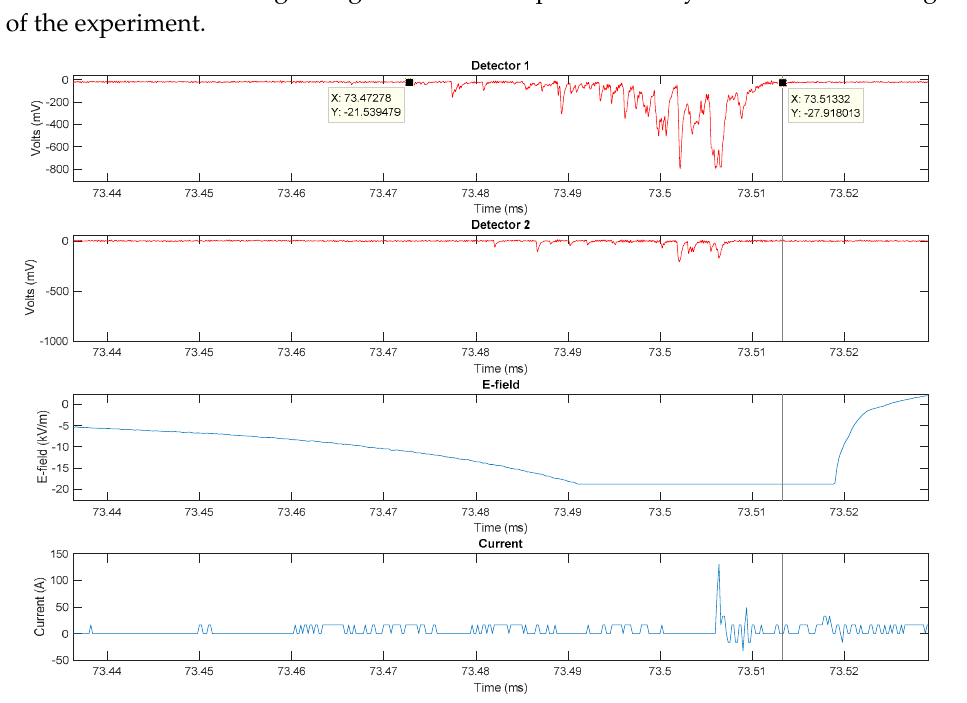
Figure 3. X-ray burst associated with the third (second subsequent) return stroke. The time t = 0 corresponds to 16:09:36.072213 UTC. X-rays are detected in both attenuated (detector 2) and unattenuated (detector 1) detectors. According to the Austrian Lightning Detection and Information System (ALDIS), this 36-kA stroke occurred at a distance of 400 m from the tower. Peak energy of the burst, derived from roughly − 800 mV peak in the un-attenuated detector, is about 4.3 MeV (this could be due to a multi-photon accumulation). The two cursor positions indicate the first and the last occurrence of X-ray peaks. This last occurrence, also shown in the black vertical cursor, happens roughly 1.4 µ s before the return stroke (RS) time of 16:09:36.145867 UTC as recorded by the ALDIS. The total duration of bursts is about 40 µ s. The seemingly continuous nature of bursts (in detector 1) could be resulting from the slow detector response. The small current peak of about 125 A (measured at the top of Gaisberg radio transmission tower (GBT)) could be due to an unconnected